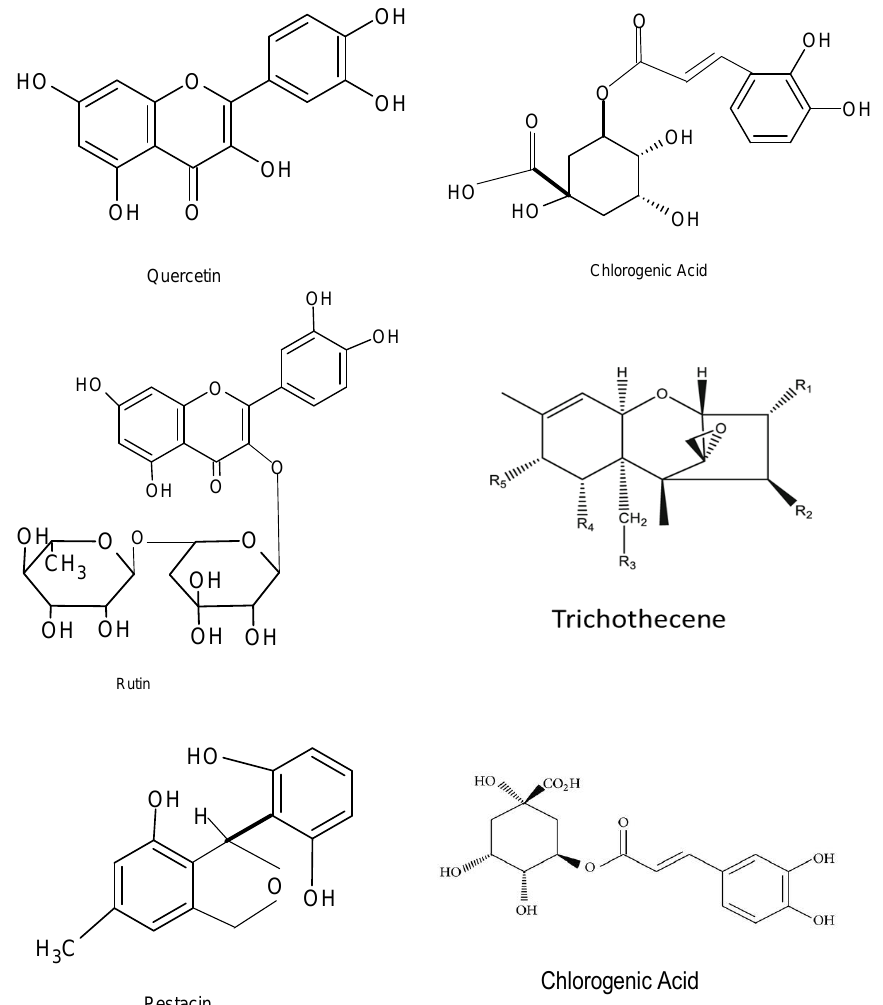
Figure 5. Chemical structures of the bioactive compounds with antioxidant activities [12].